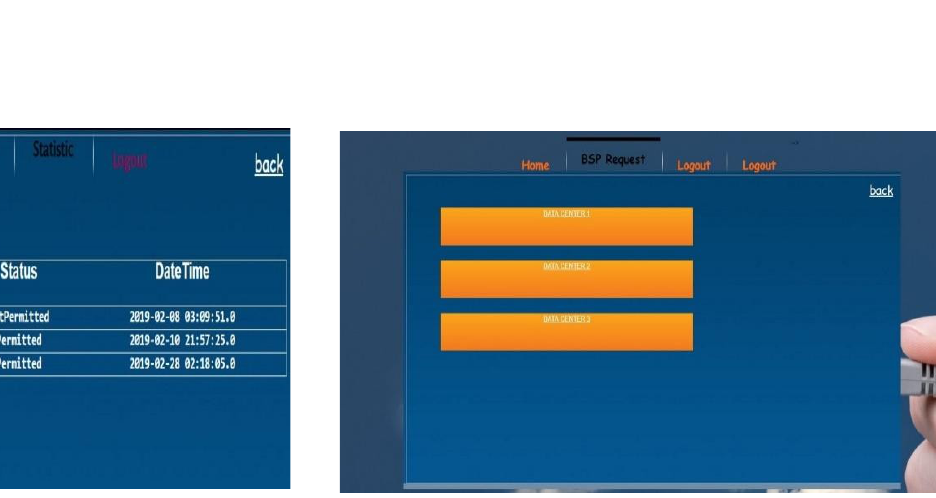
Figure 8. ISP Multi-Server System